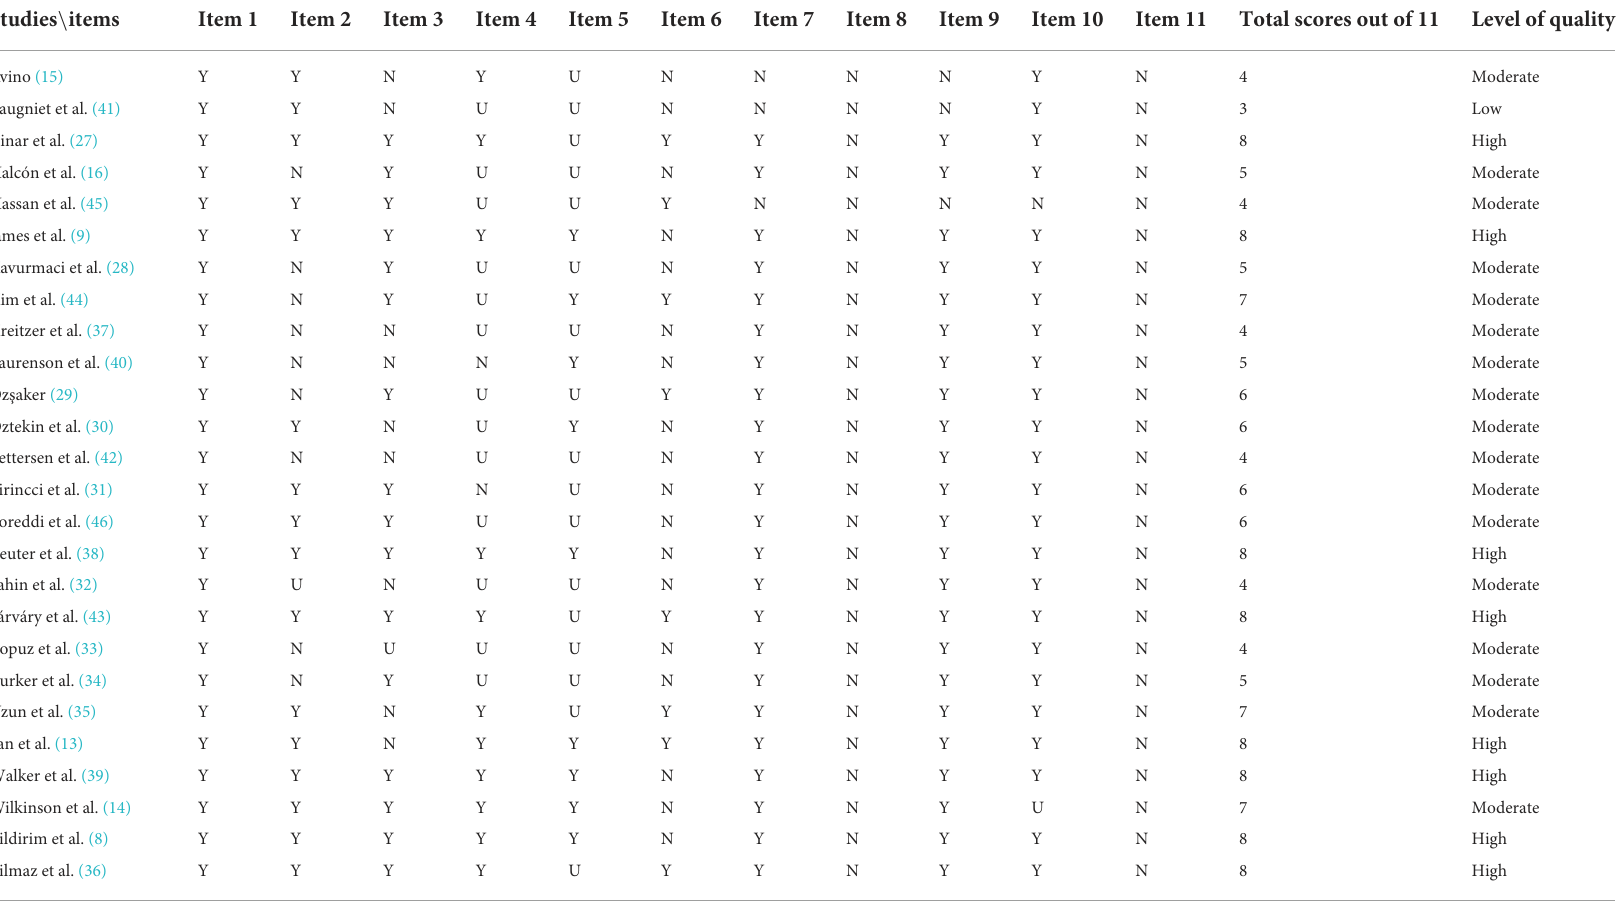
TABLE 2 Methodological quality assessment of 26 included studies based on AHRQ checklist. Studies \